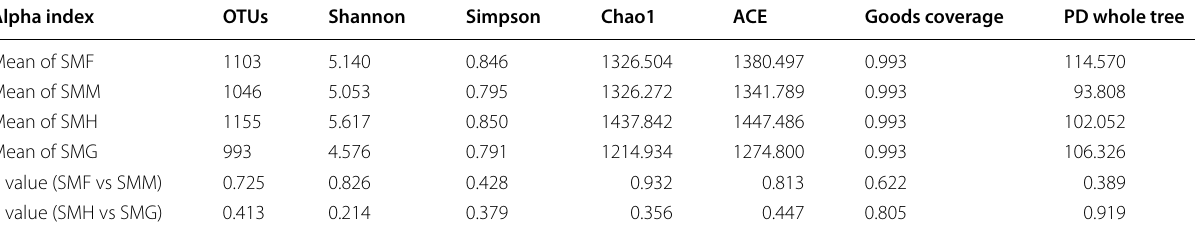
Table 1 Multiple regression analysis of the influence of gender and sampling site on the alpha diversity of short-faced moles’ intestinal microbial diversity